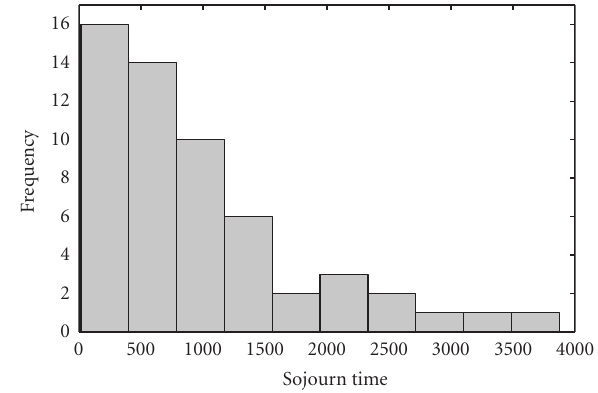
Figure 8: Histogram of FDI sojourn time.